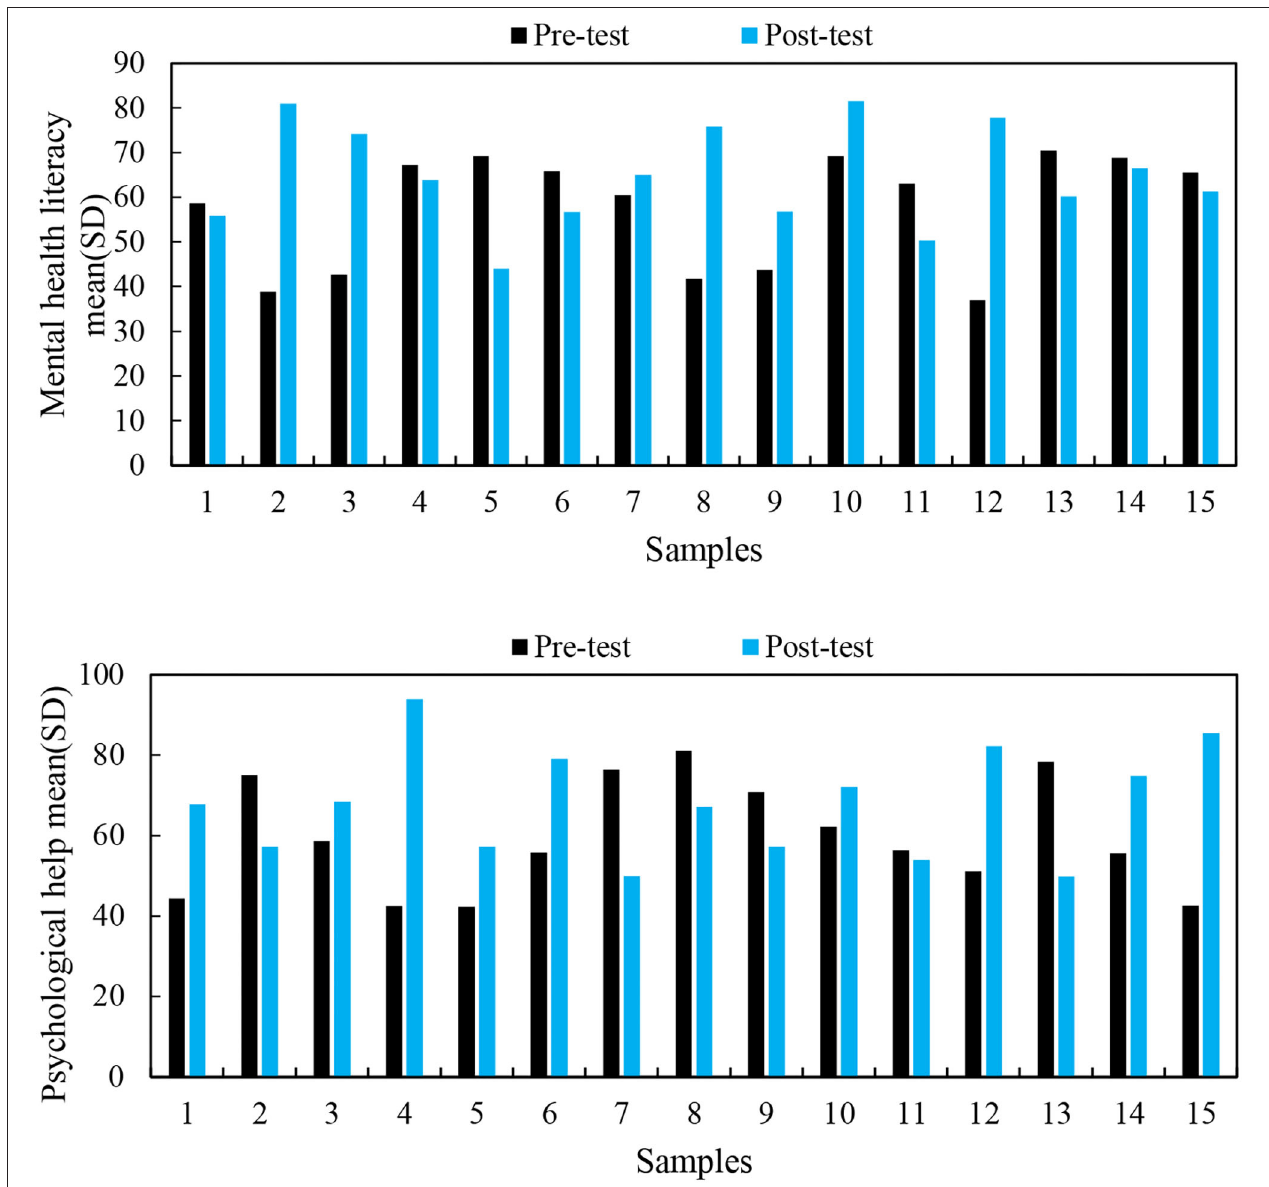
FIGURE 5 | Mental health literacy and willingness to ask for professional psychological help of the experimental group and the control